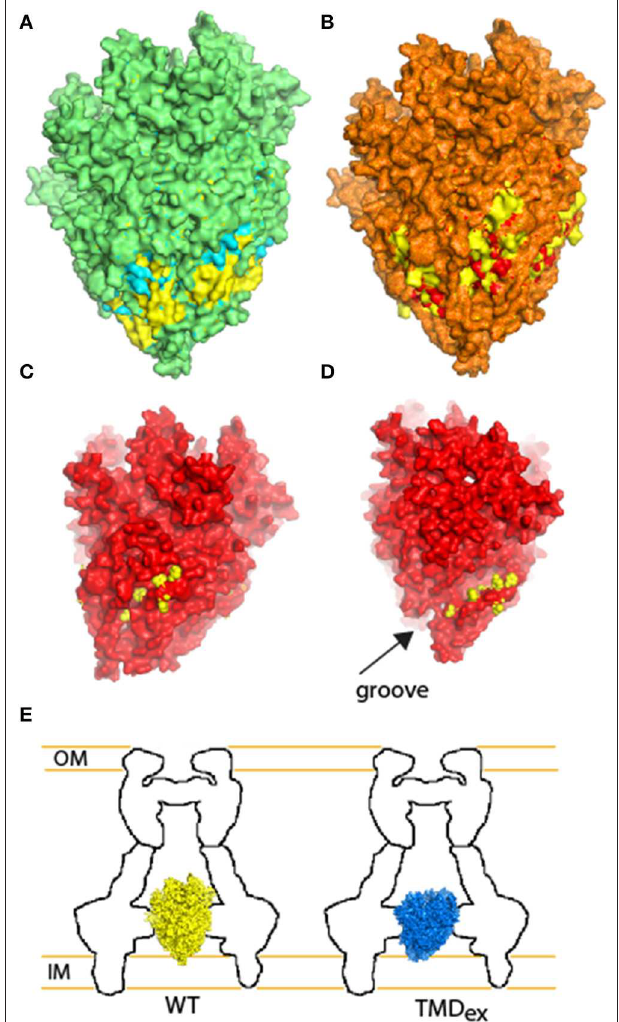
FIGURE 9 | Illustration of the structural adaptations predicted for the TMD-exchanged EscR 5 S 4 T complexes in comparison with the WT complex. (A) Overlapping the WT structure of EscR 5 S 4 T (marked in yellow) with the TMD1-exchanged (marked in cyan). Overlaying regions are displayed in green, regions that bulge over the WT complex are marked in cyan (expansion of the TMD1-exchange), and indentations are marked in yellow (concave of the TMD1-exchange). (B) Overlapping of WT structure (yellow) and TMD2-exchanged (red). Overlaying regions are displayed in orange, regions that bulge over the WT complex are marked in red, and indentations are marked in yellow. (C) Side-view of the TMD2-exchange complex (red) reveals a large void, which is occupied by bulky amino acids in the WT complex (marked in yellow). (D) Side-view of the TMD2-exchange complex (red) reveals reduction of density close to a groove found within the EscR 5 S 4 T. The amino acids of the WT complex that are absent from the TMD2 mutant complex are marked in yellow. (E) Schematic model of the WT (yellow) and TMD-exchanged (blue) export apparatus complex within the T3SS. Although the complex assembles, the interaction interface between the substructures is